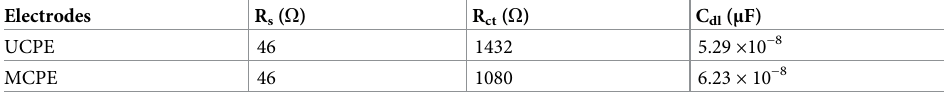
Table 1. Summary of calculated equivalent circuit parameters for the UCPE and